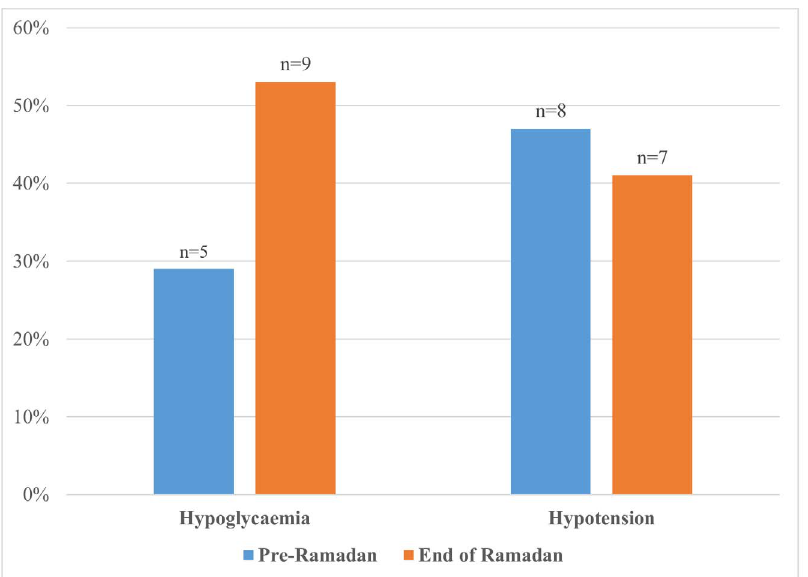
Fig. 1. Percentage of observed hypotensive episodes during dialysis (systolic blood pressure , 100 mmHg) and self-reported hypoglycaemic episodes in patients with diabetes pre- and end of Ramadan